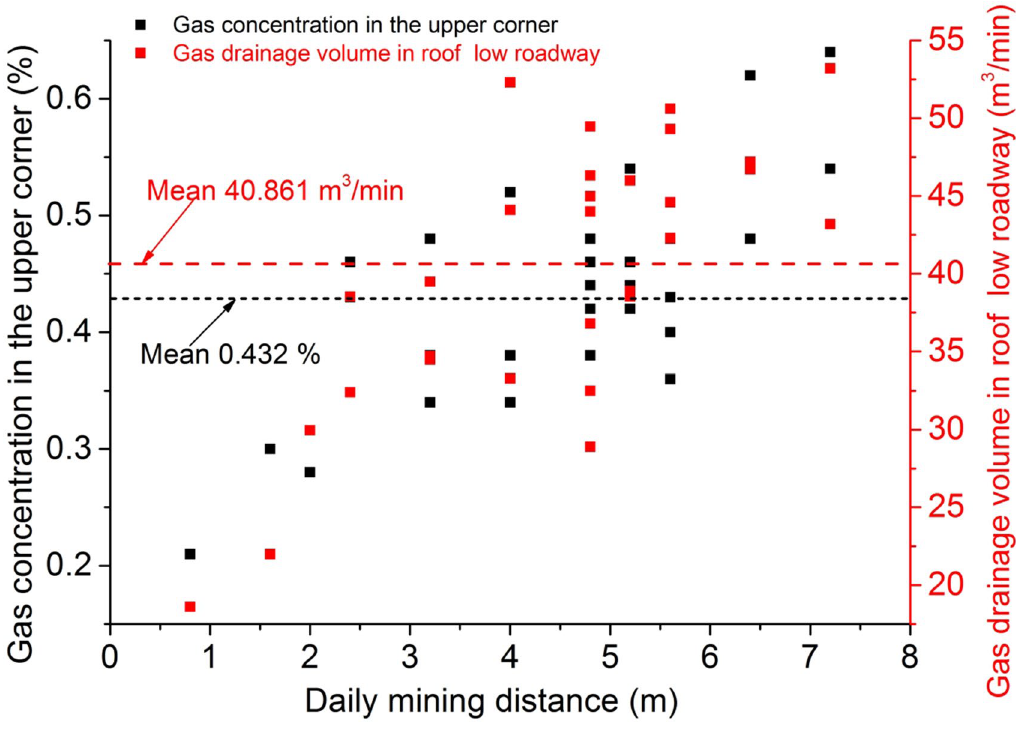
Figure 12. Relationship between daily mining distance and